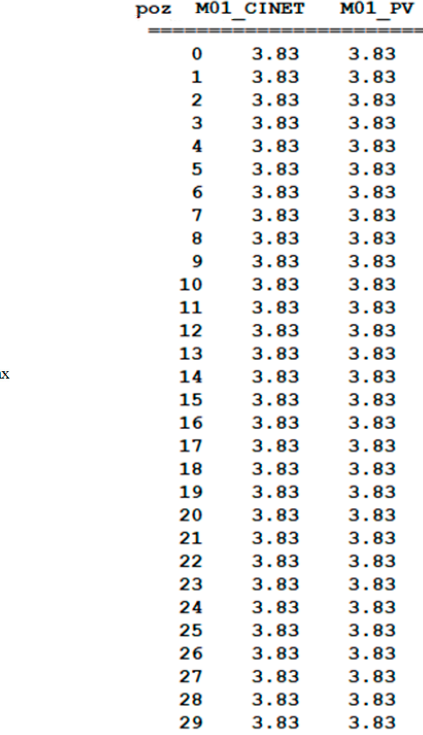
Figure 12. Kinetostatic analysis of the index finger—final results for active torque.